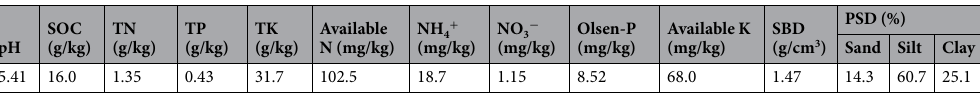
Table 5. The agro-characteristics of top paddy soil prior to the experiment. SOC: soil organic carbon, TN: total N, TP: total P, TK: total K, SBD: soil bulk density, PSD: particle size